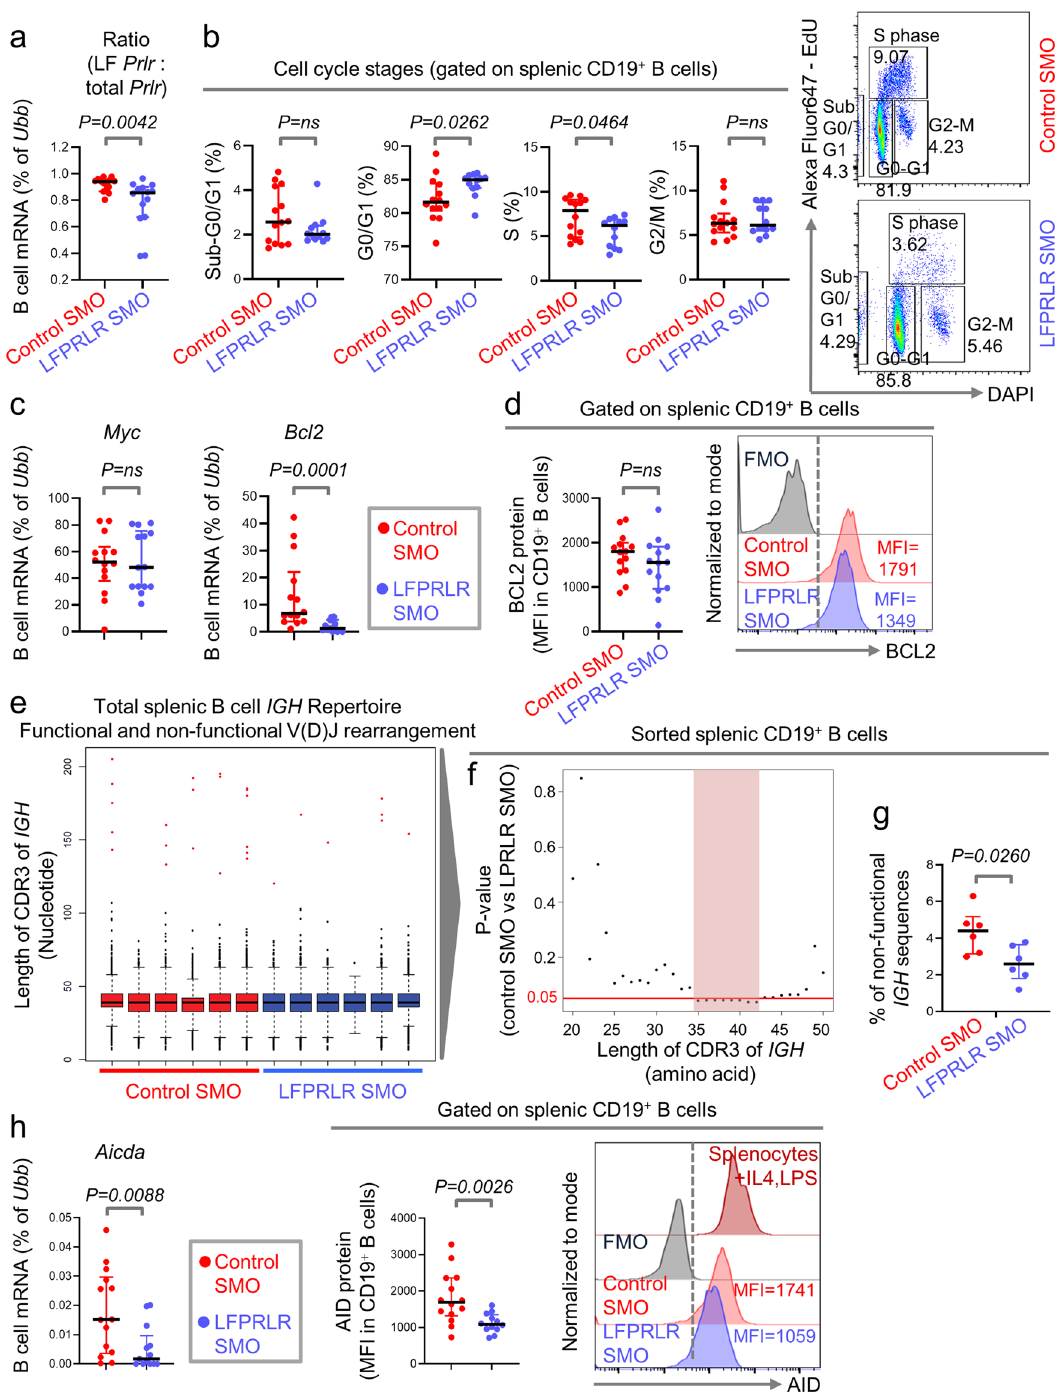
Fig. 2 Knockdown of LFPRLR in SLE-prone mice decreases factors associated with the risk of lymphoma initiation. a – d Veri fi cation of LFPRLR knockdown in isolated B cells by qPCR ( a ), percentages of B cells in sub G0/G1, G0/G1, S, and G2/M phases with representative fl ow cytometry plots ( b ), B-cell speci fi c transcript levels of Myc , Bcl2 by qPCR ( c ), and BCL2 protein by fl ow cytometry ( d ) in spleens of MRL-lpr mice treated with control SMO ( n = 14, red) or LFPRLR SMO ( n = 14, blue). e – g Next-generation sequencing of total IGH repertoire (GSE207186) to compare spectratype of splenic B cells ( e ), and frequencies of splenic B cells with IGH CDR3 ≥ 20aa ( f ), and frequencies of B cells with non-productive IGH rearrangements ( g ) in MRL-lpr SLE- prone mice treated with control ( n = 6, red) or LFPRLR SMO ( n = 6, blue). h Aicda mRNA and protein levels in splenic B cells and representative histograms for AID protein staining in control SMO-treated ( n = 14, red) and LFPRLR SMO-treated ( n = 14, blue) MRL-lpr mice by fl ow cytometry. Splenic WBCs from wildtype mice cultured with IL-4 and LPS were used as positive controls for AID staining. Each dot in qPCR analyses of transcripts corresponds to the mean expression of that gene in one mouse calculated from 3 technical replicates. Ubb was used as the house-keeping gene in qPCR. Graphs show median± interquartile range. Exact p -values were calculated using the Mann – Whitney U test. ns non-signi fi cant, FMO fl uorescence minus one control, MFI median fl uorescence intensity.